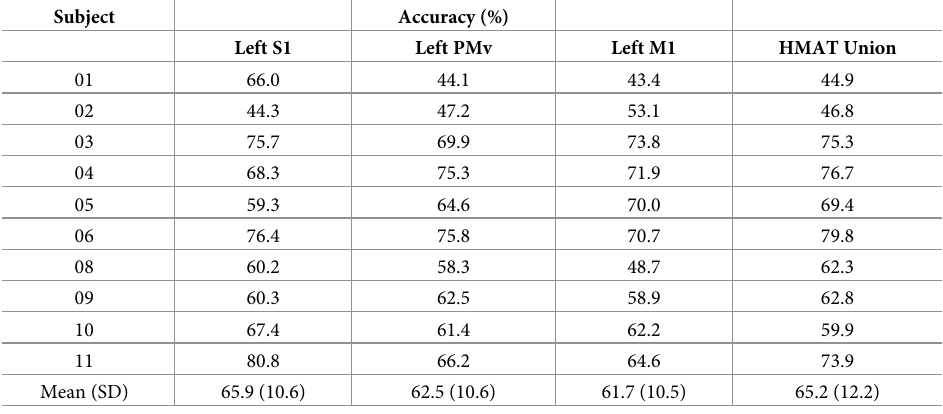
Table 2. Top 3 regional accuracies within the Human Motor Area Template (HMAT) and accuracy when using all regions (HMAT